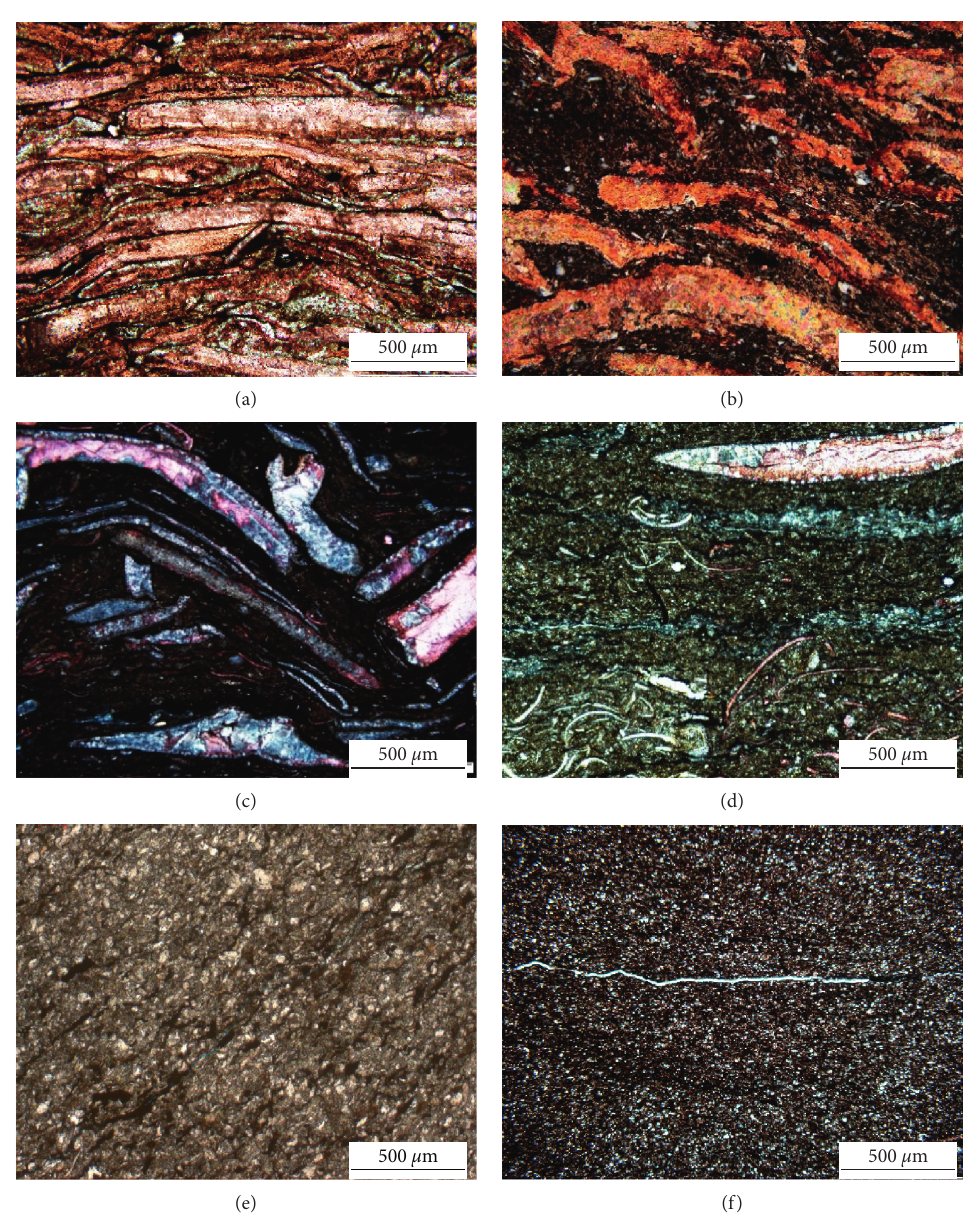
Figure 7: Microscopic lithology characteristics of fine-grained rocks in the Da’anzhai Member in the northern Sichuan Basin. (a) Shell limestone, North-1 Well, 3755.5m ( − ). (b) Shell shale, North-1 Well, 3759.6m ( − ). (c) Shell shale, shell silicification, North-1 Well, 3746.7m (+). (d) Laminar shell shale, North-1 Well, 3789.1 m ( − ). (e) Weak laminar silt-bearing shale, North-2 Well, 3990m ( − ). (f) Shale or mudstone and cracks, North-1 Well, 3750.7m ( −